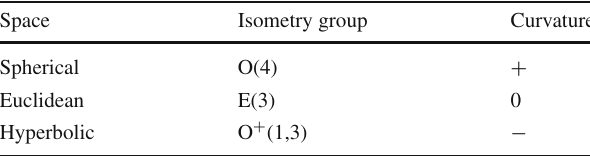
Table 2 3D background geometries with O(3) as the stabilizer Space Isometry group Curvature